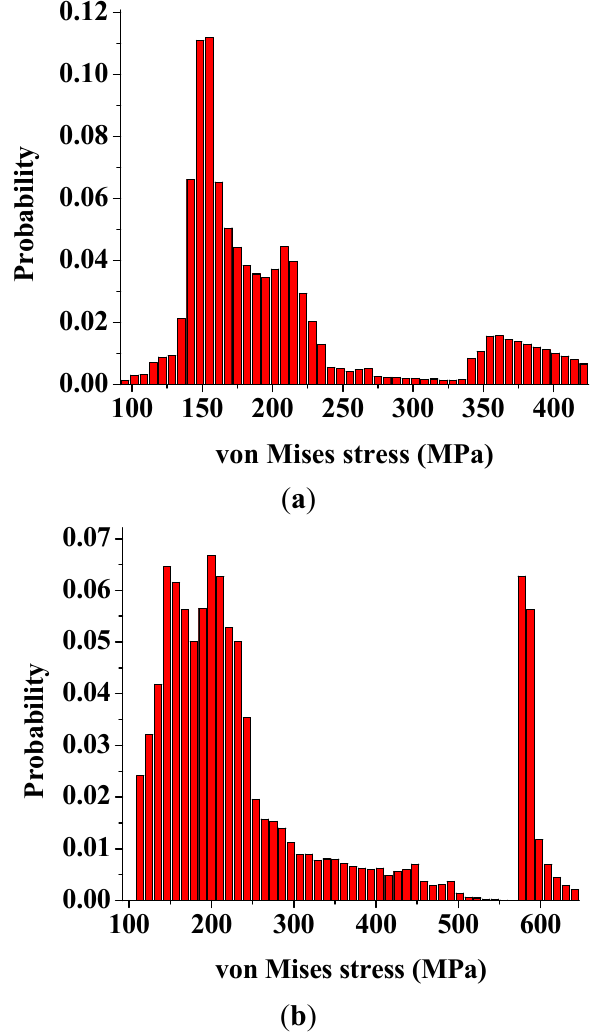
Figure 6. Probability distributions of the von Mises stress of nanocomposites for ( a ) E i = 0.85 GPa; and ( b ) E i = 3.4